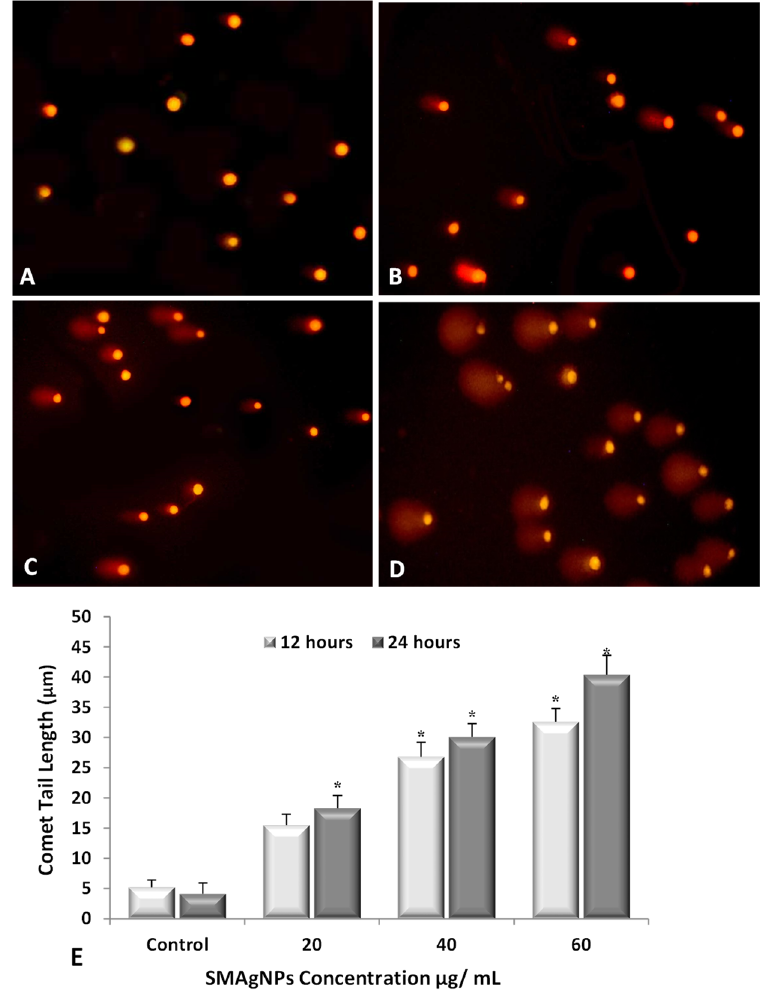
Figure 12. Detection of DNA damage determined by comet assay in HepG2 cells exposed to different concentrations of SMAgNPs for 24 h. The representative images of cells with comet tails, which represent DNA damage (magnification 20 × ). Control cells ( A ), 20 µ g/mL ( B ), 40 µ g/mL ( C ), and 60 µ g/mL ( D ). The comet tail length ( µ m) for all treatments is expressed as mean ± SD from three independent experiments ( E ), (* Significant, p <